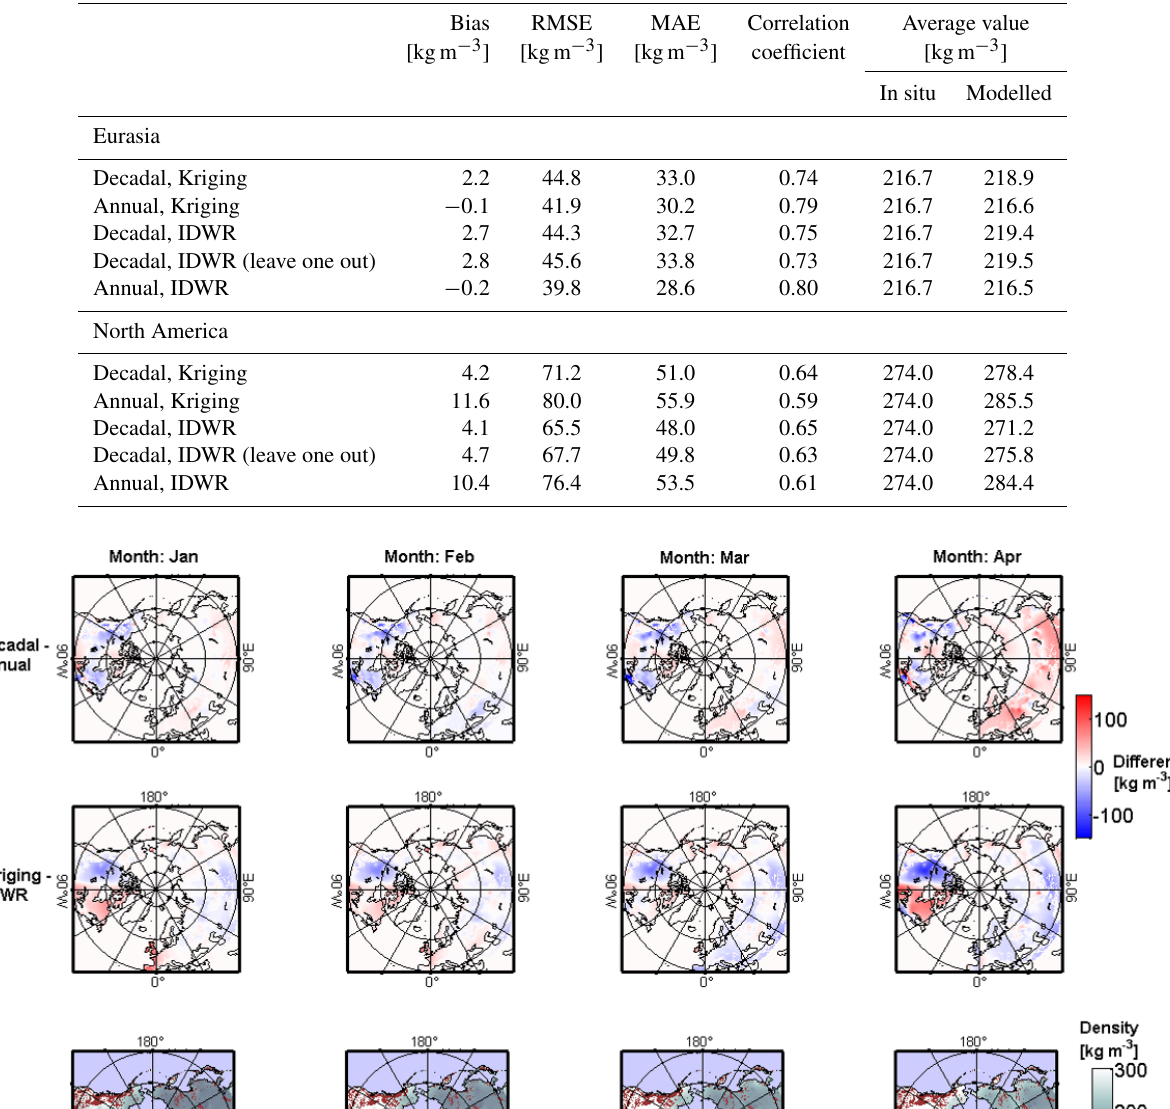
Table 2. Summary of validation parameters for three snow density sets for 2000–2009.